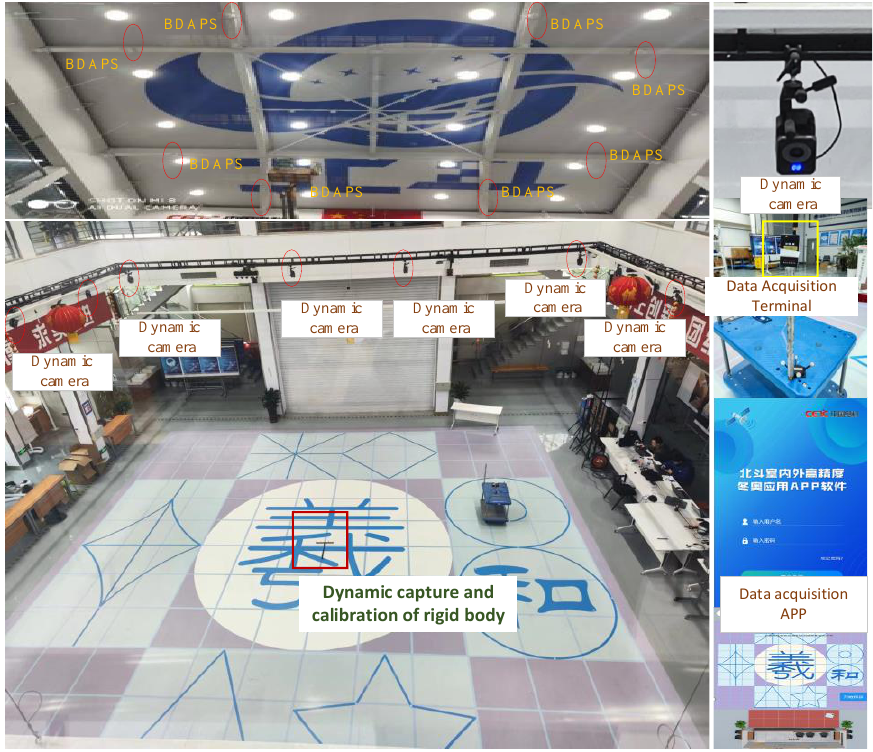
Figure 5. Test scenario.